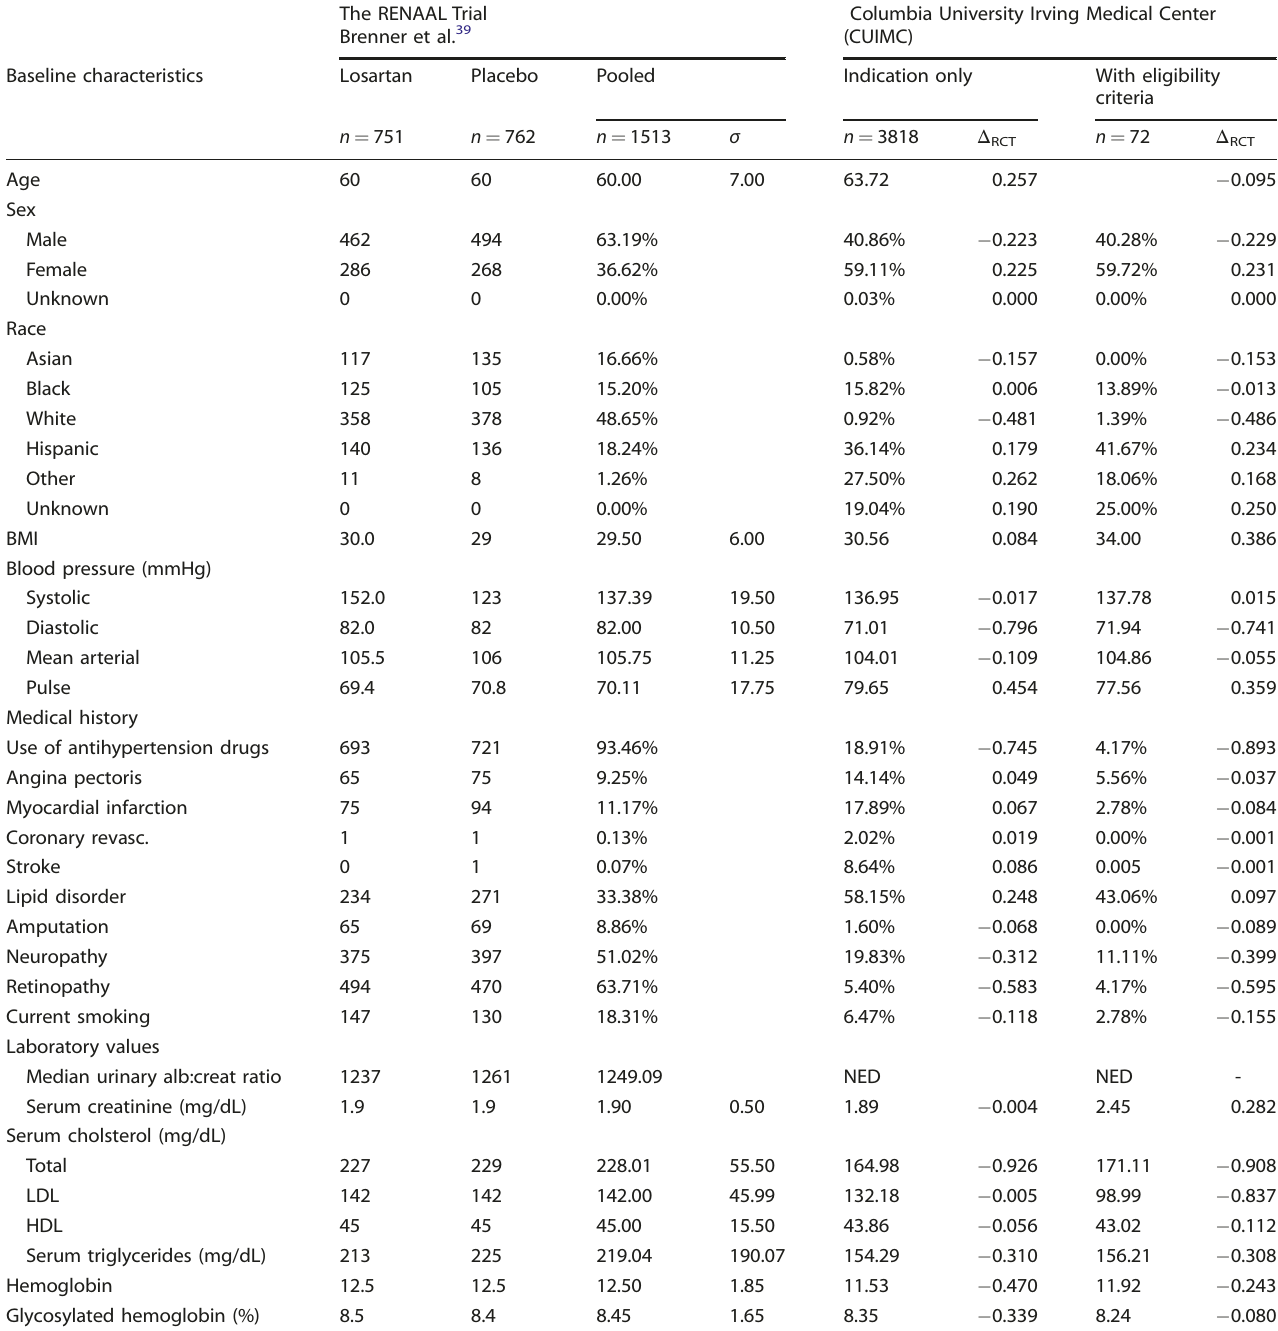
Table 3. Results for losartan vs. placebo trial